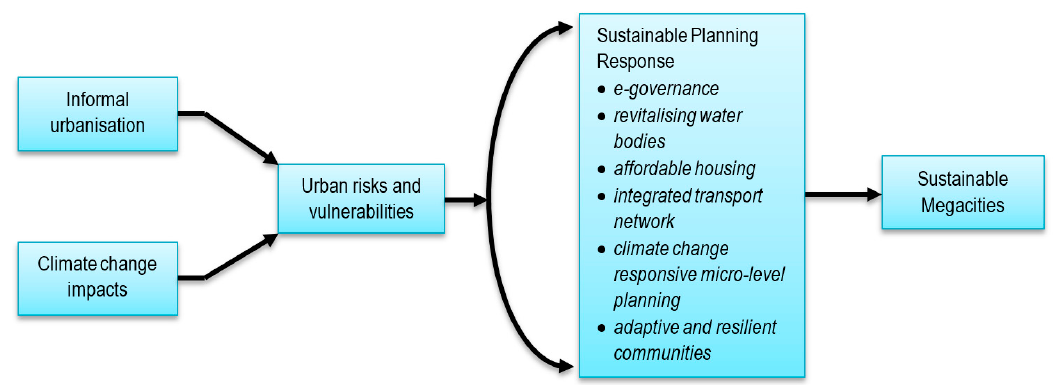
Figure 6. A framework for sustainable urban development in megacities.